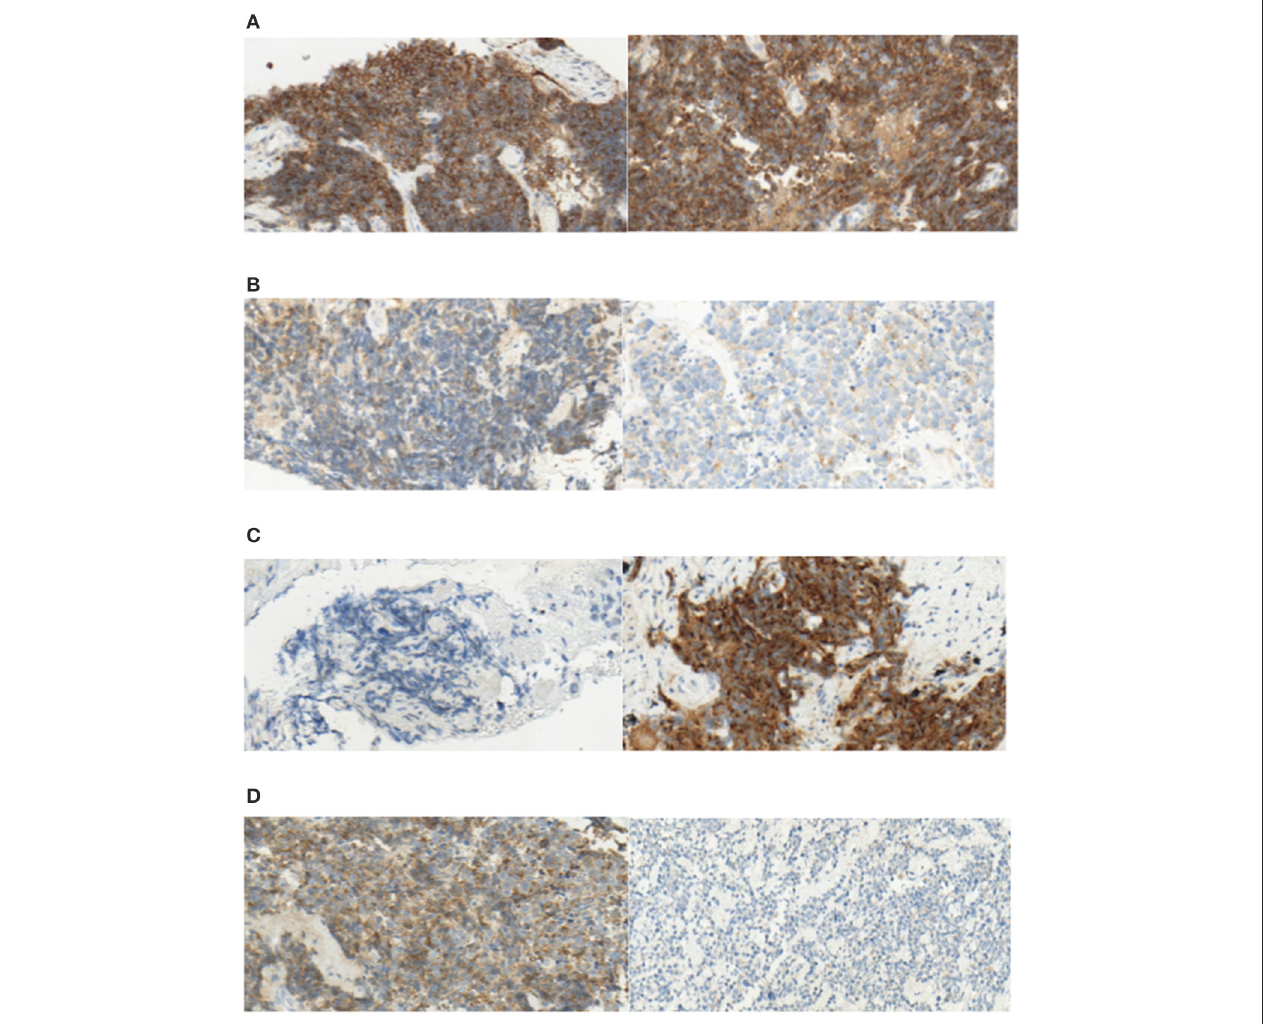
FIGURE 2 | Exemplary pictures of DLL3 staining patterns in paired chemonaive (left) and chemorelapsed (right) SCLC samples. (A) Both high DLL3 expression (TPS > 50%, H-score > 150), (B) Both low DLL3 expression (TPS < 50%, H-score < 150), (C) “DLL3 up” [low expression in chemonaive sample (TPS < 50%, H-score < 150) and high expression in chemorelapsed sample (TPS > 50%, H-score > 150)], (D) “DLL3 down” [low expression in chemorelapsed sample (TPS < 50%, H-score < 150) and high expression in chemonaive sample (TPS > 50%, H-score > 150); original magnification × 40].